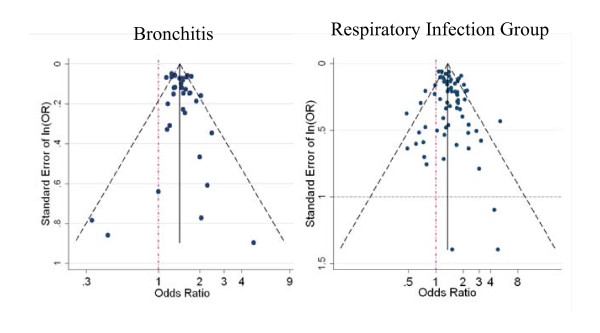
Funnel plots for bronchitis and the respiratory infection group. The horizontal line in the plot for the Respiratory Infection Group indicates the line (Standard Error = 1) below which asymmetric data points were omitted in a secondary analysis.